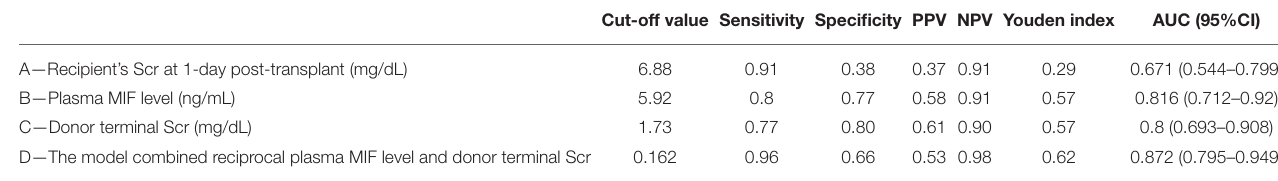
TABLE 3 | Sensitivity, specificity, and predictive values for predicting delayed graft function at optimum cut-off value of recipient and donor characteristic.